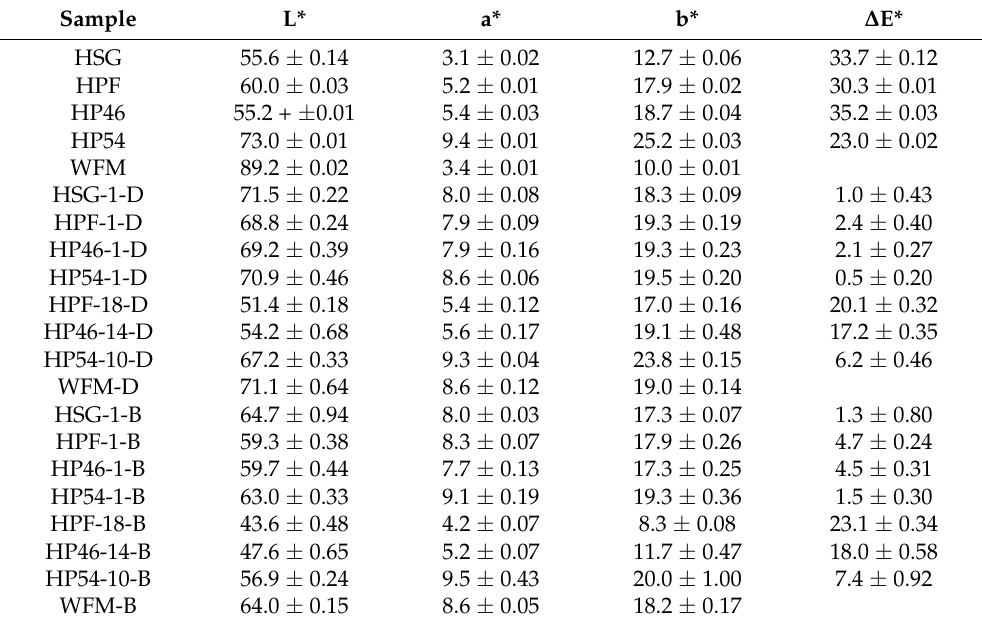
Table 2. Colour of all raw materials: doughs (-D) and breads (-B) expressed in CIELAB colour space. L*—luminosity; a*—red to green; b*—yellow to blue; ∆ E*—colour difference; HSG—hemp seed grit; HPF—hemp press cake flour; HP46—hemp press cake flour protein (46%); HP54—hemp press cake flour protein (54%); WFM—half-and-half mixture of wheat and whole wheat flour. Raw materials were measured in triplicate, and doughs and breads were measured nine